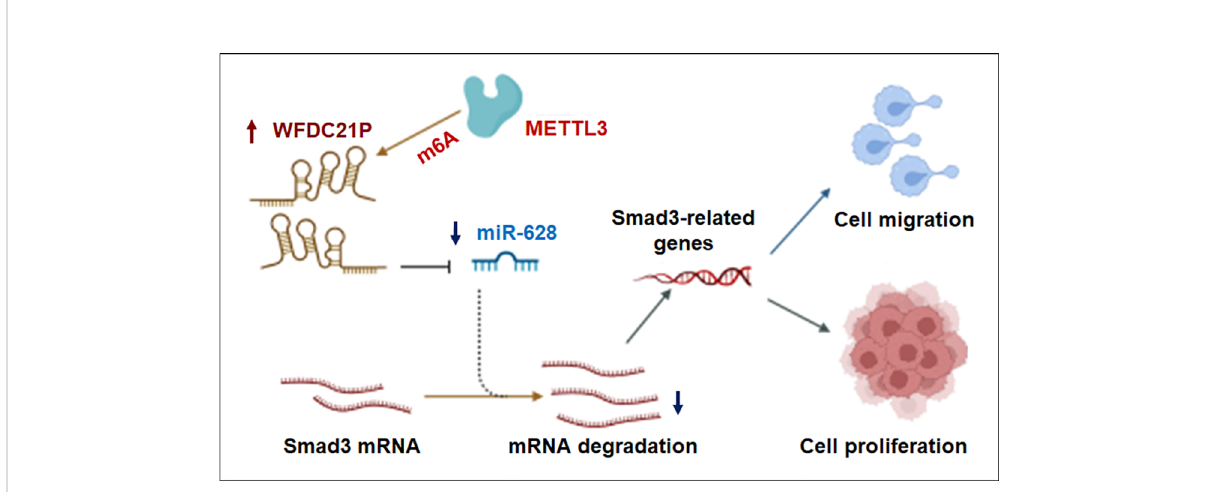
FIGURE 7 Proposed model by which METTL3 promoted lncRNA-WFDC21P levels and triple-negative breast cancer progression. Through the WFDC21P/ miR-628-5p/Smad3 axis, WFDC21P signi fi cantly promoted BC cell proliferation and metastasis and negatively regulating miR-628-5p, whereas miR-628-5p suppressed BC cell proliferation and metastasis by negatively regulating Smad3-related gene expression. Moreover, METTL3 overexpression increased WFDC21P and its m6A levels and further regulated BC cell proliferation and